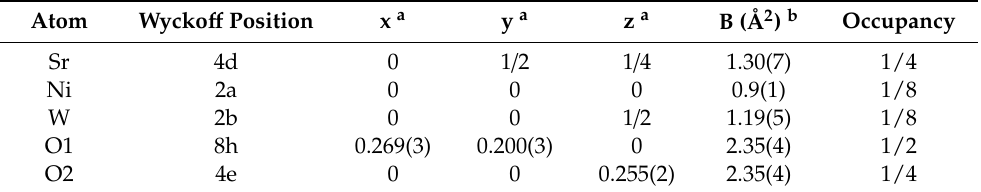
Figure 2. Calculated (black) vs. experimental (red) powder X-ray diffraction pattern for Sr 2 NiWO 6 . Table 3. Structural parameters for Sr 2 NiWO 6 extracted at room temperature (292 K). The site occupancies are expressed in terms of the ratio m:M—site multiplicity:multiplicity of a general position (16).